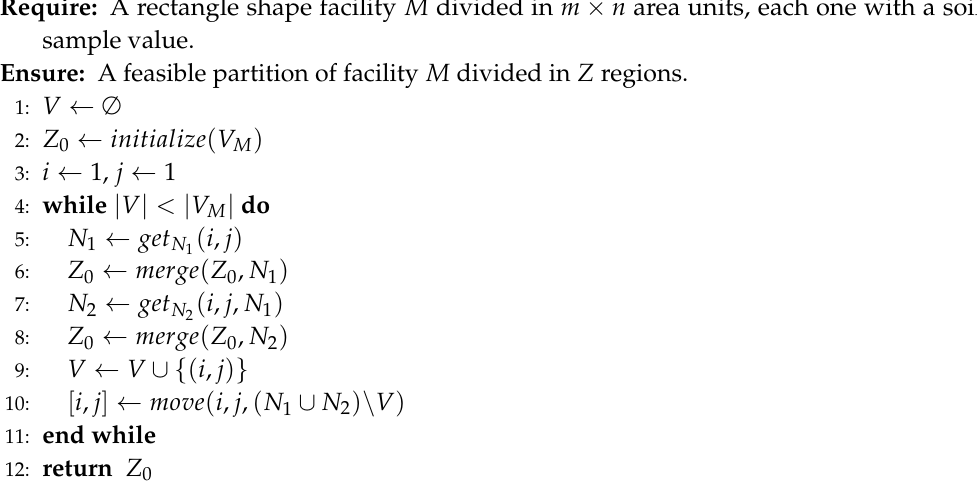
Algorithm 1 A simple greedy heuristic for the SSMZ